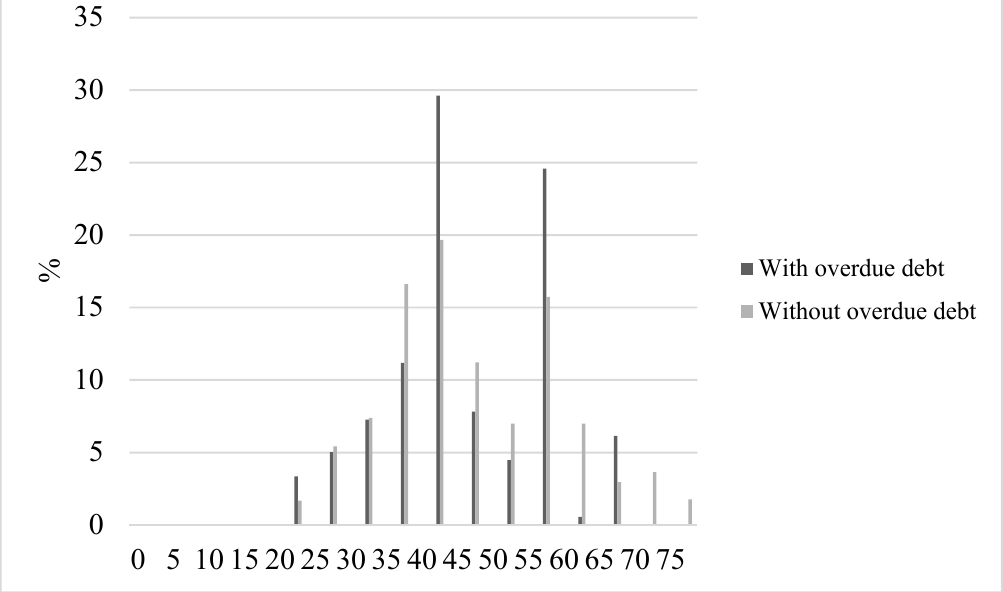
Figure 6. Distributions of the settlement development indicator in the subsamples of households with and without overdue debts. Source: Questionnaire-based survey, small settlements of BAZ County, Hungary, 2019.